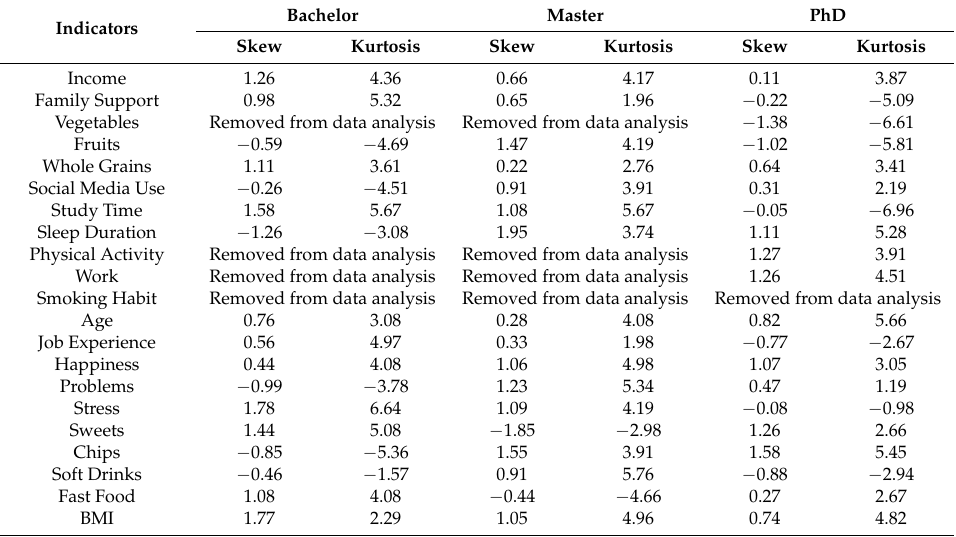
Table 5. Normality test based on the most significant indicators according to factor loading analysis.